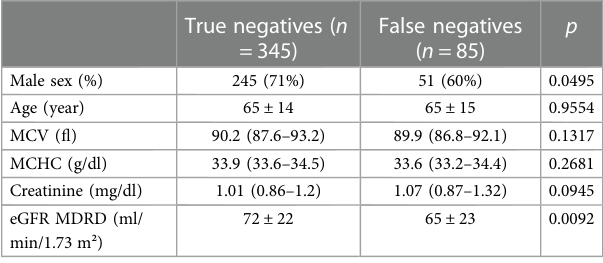
TABLE 2 Subgroup analysis of the true negative and false negative populations.